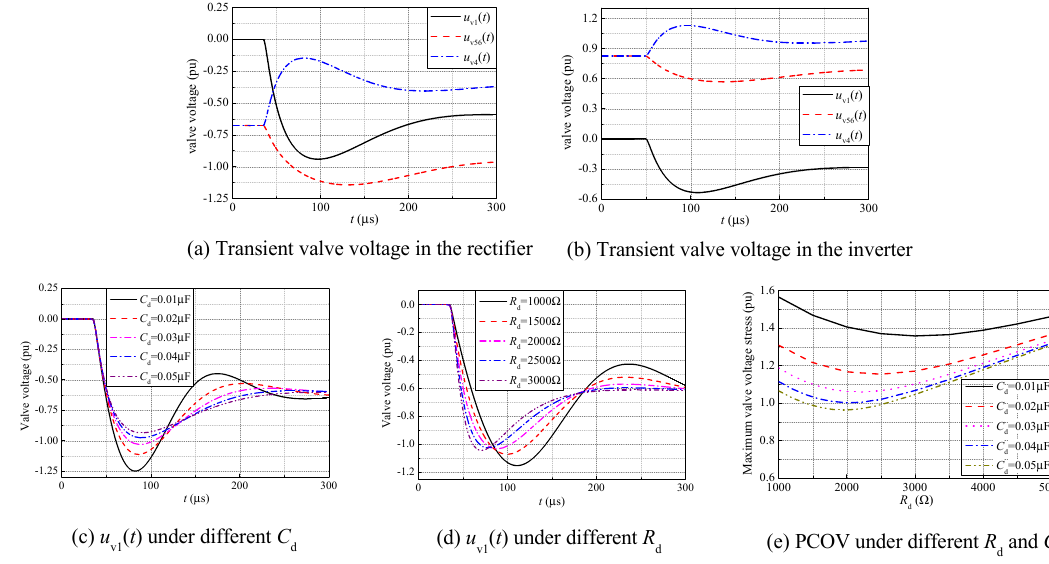
Figure 5. Characteristics of Commutation Overshoot.